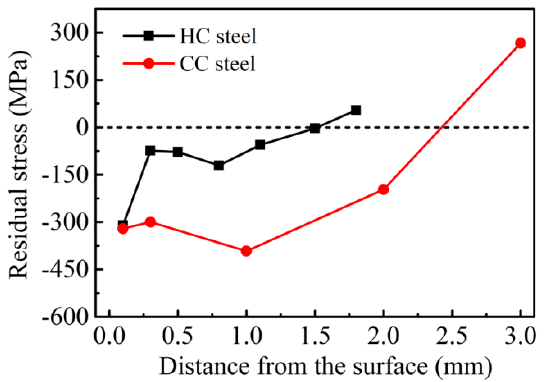
Figure 6. Residual stress distributions of the two steels after heat treatment. Notes: Residual stress at various depths was measured by an X-350A X-ray stress meter by means of the electrochemical corrosion layer stripping and electropolishing method.